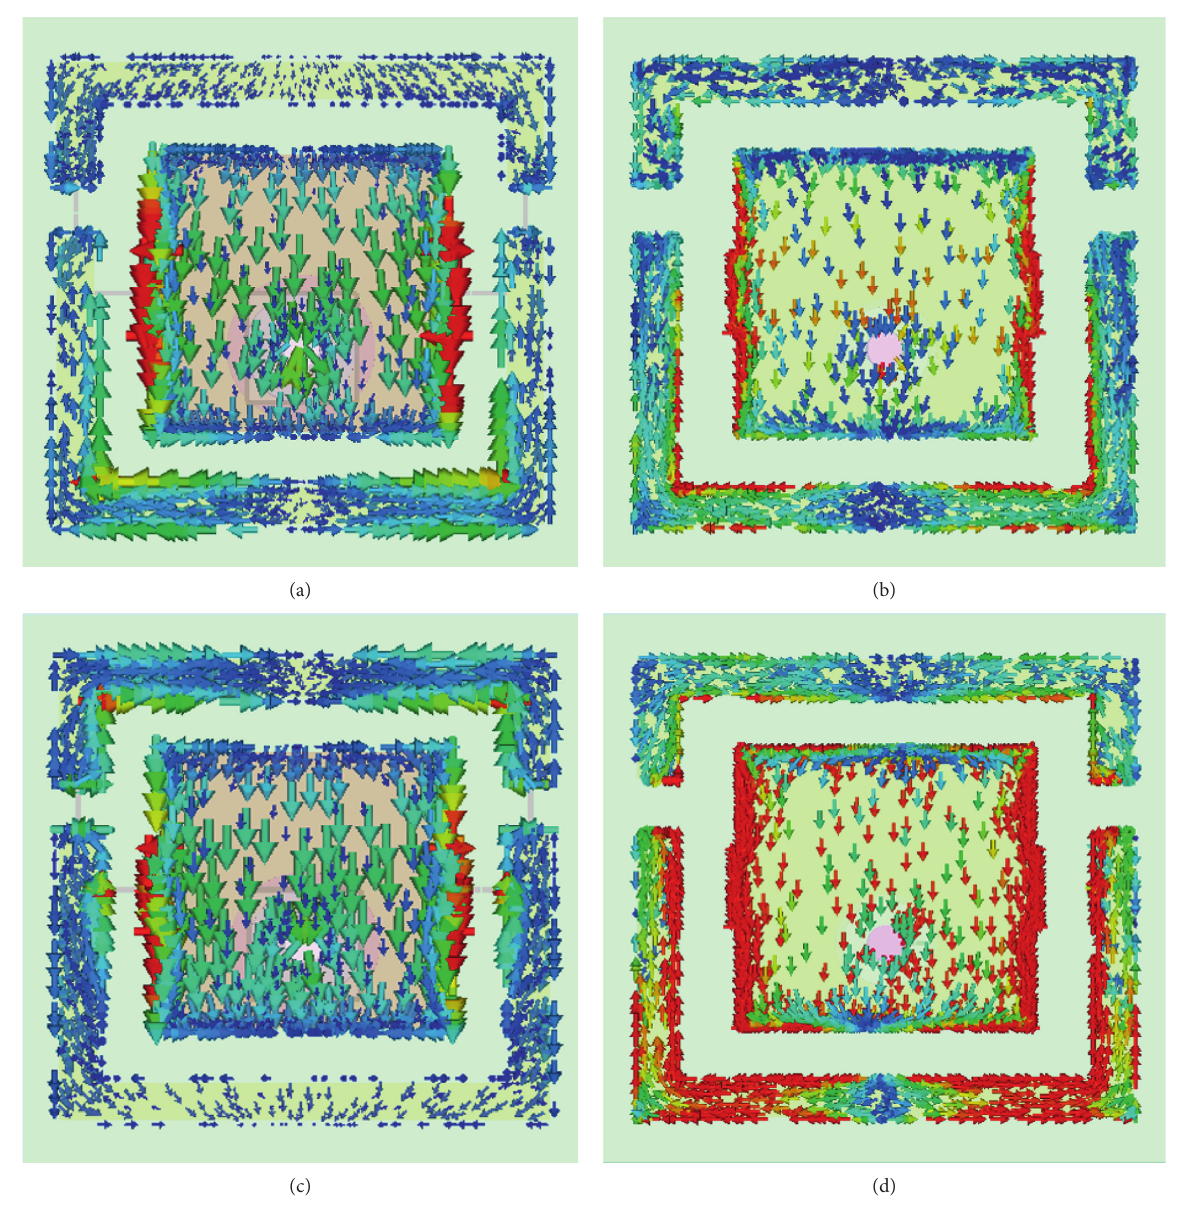
Figure 3: Surface current analysis; (a) surface current distribution on radiation state (“OFF” state); (b) surface current distribution on scattering state (“OFF” state); (c) surface current distribution on radiation state (“ON” state); (d) surface current distribution on scattering state (“ON”